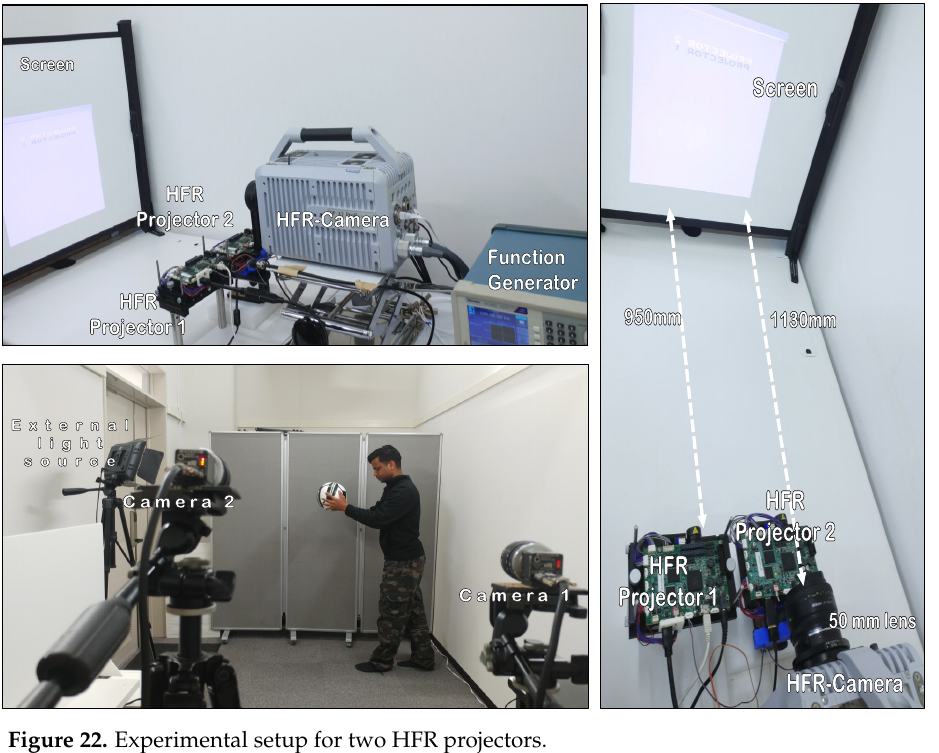
Figure 22. Experimental setup for two HFR projectors.